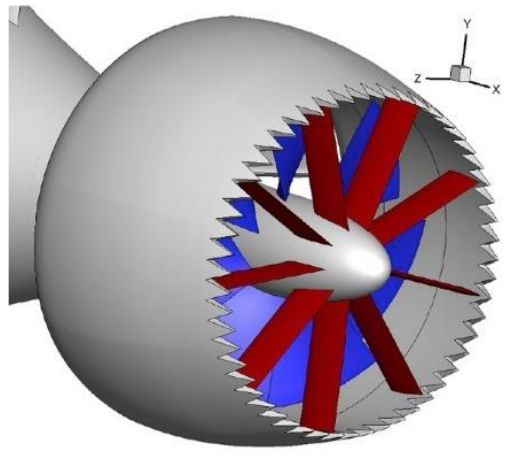
Figure 16. Geometry of pump-jet with sawtooth duct.